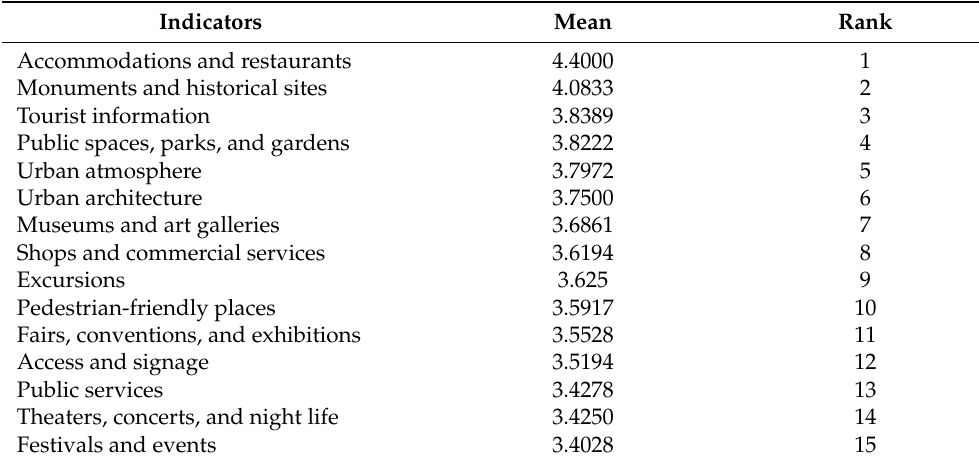
Table 2. Tourist attraction variables and their level of